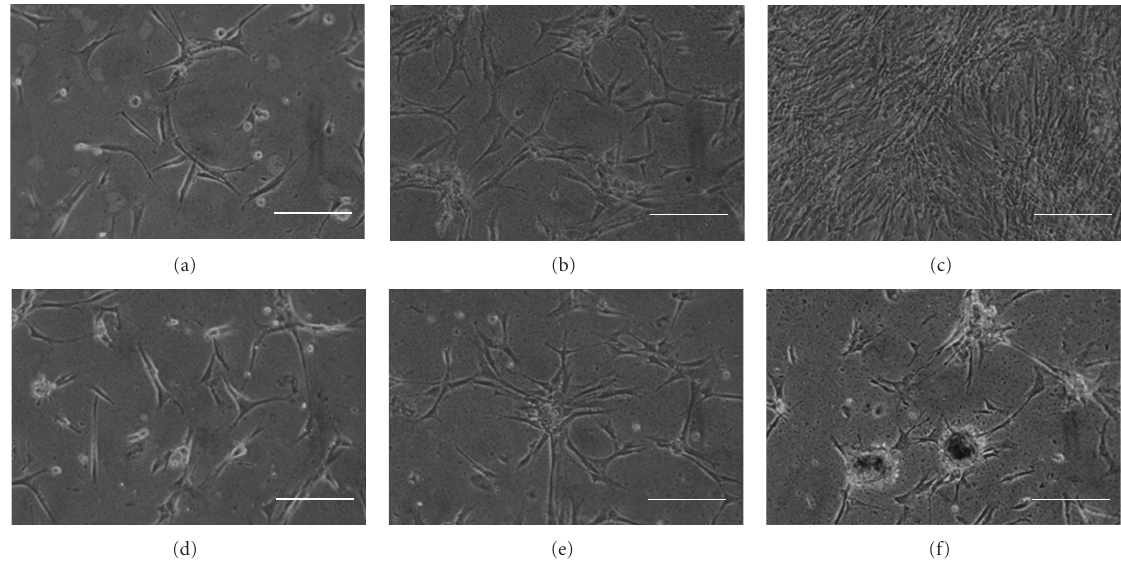
Figure 2: Morphology of cells seeded on Fe-alginate films. Cells were cultured on high-G (a–c) and high-M (d–f) alginate films. Phase- contrast micrographs were taken at 1 day (a, d), 5 days (b, e), and 8 days (c, f) after cell seeding. Bar equals 200 μ